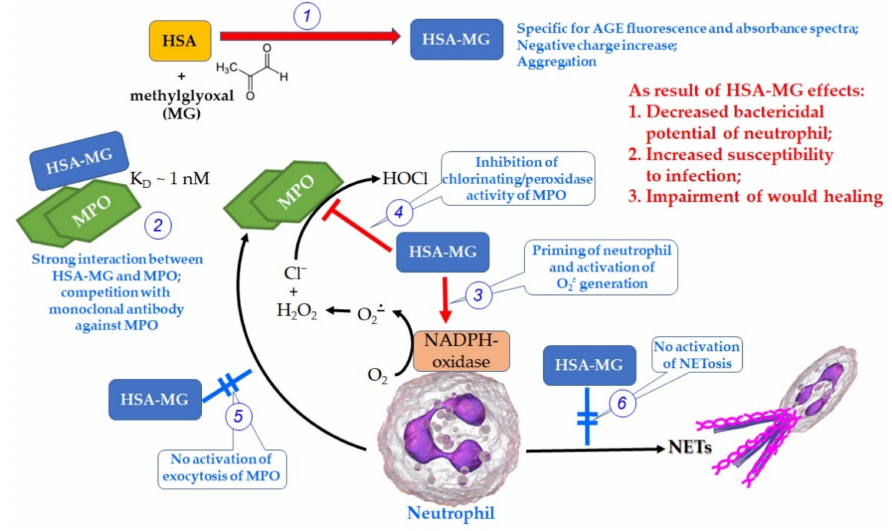
Figure 12. Summary scheme for the effect of HSA-MG on the function of MPO and neutrophils in the conditions of hyperglycemia modeling. Explanations are in the